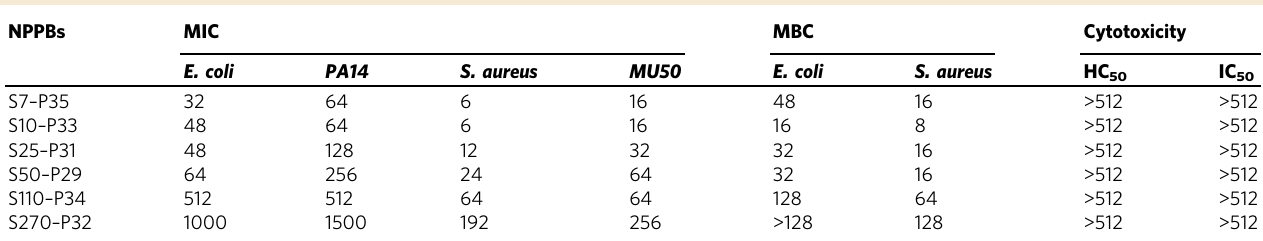
Table 2 Antimicrobial activity and toxicity of model NPPBs (unit: μ g/mL). NPPBs MIC MBC Cytotoxicity E. coli PA14 S. aureus MU50 E. coli